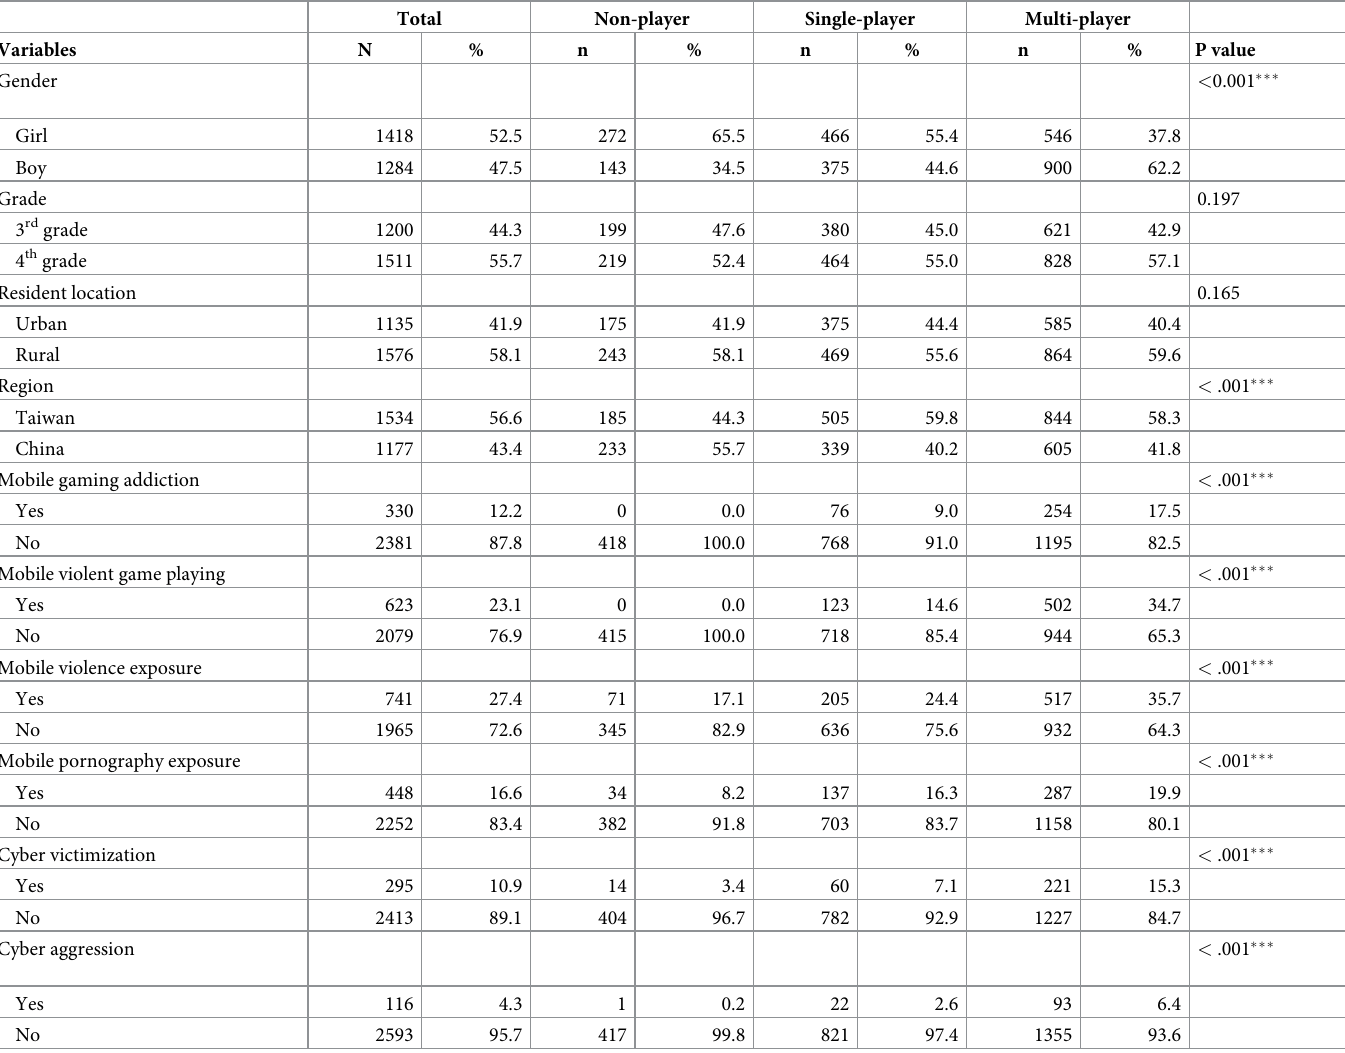
Table 3. Children’s demographic characteristics and online risks by gaming